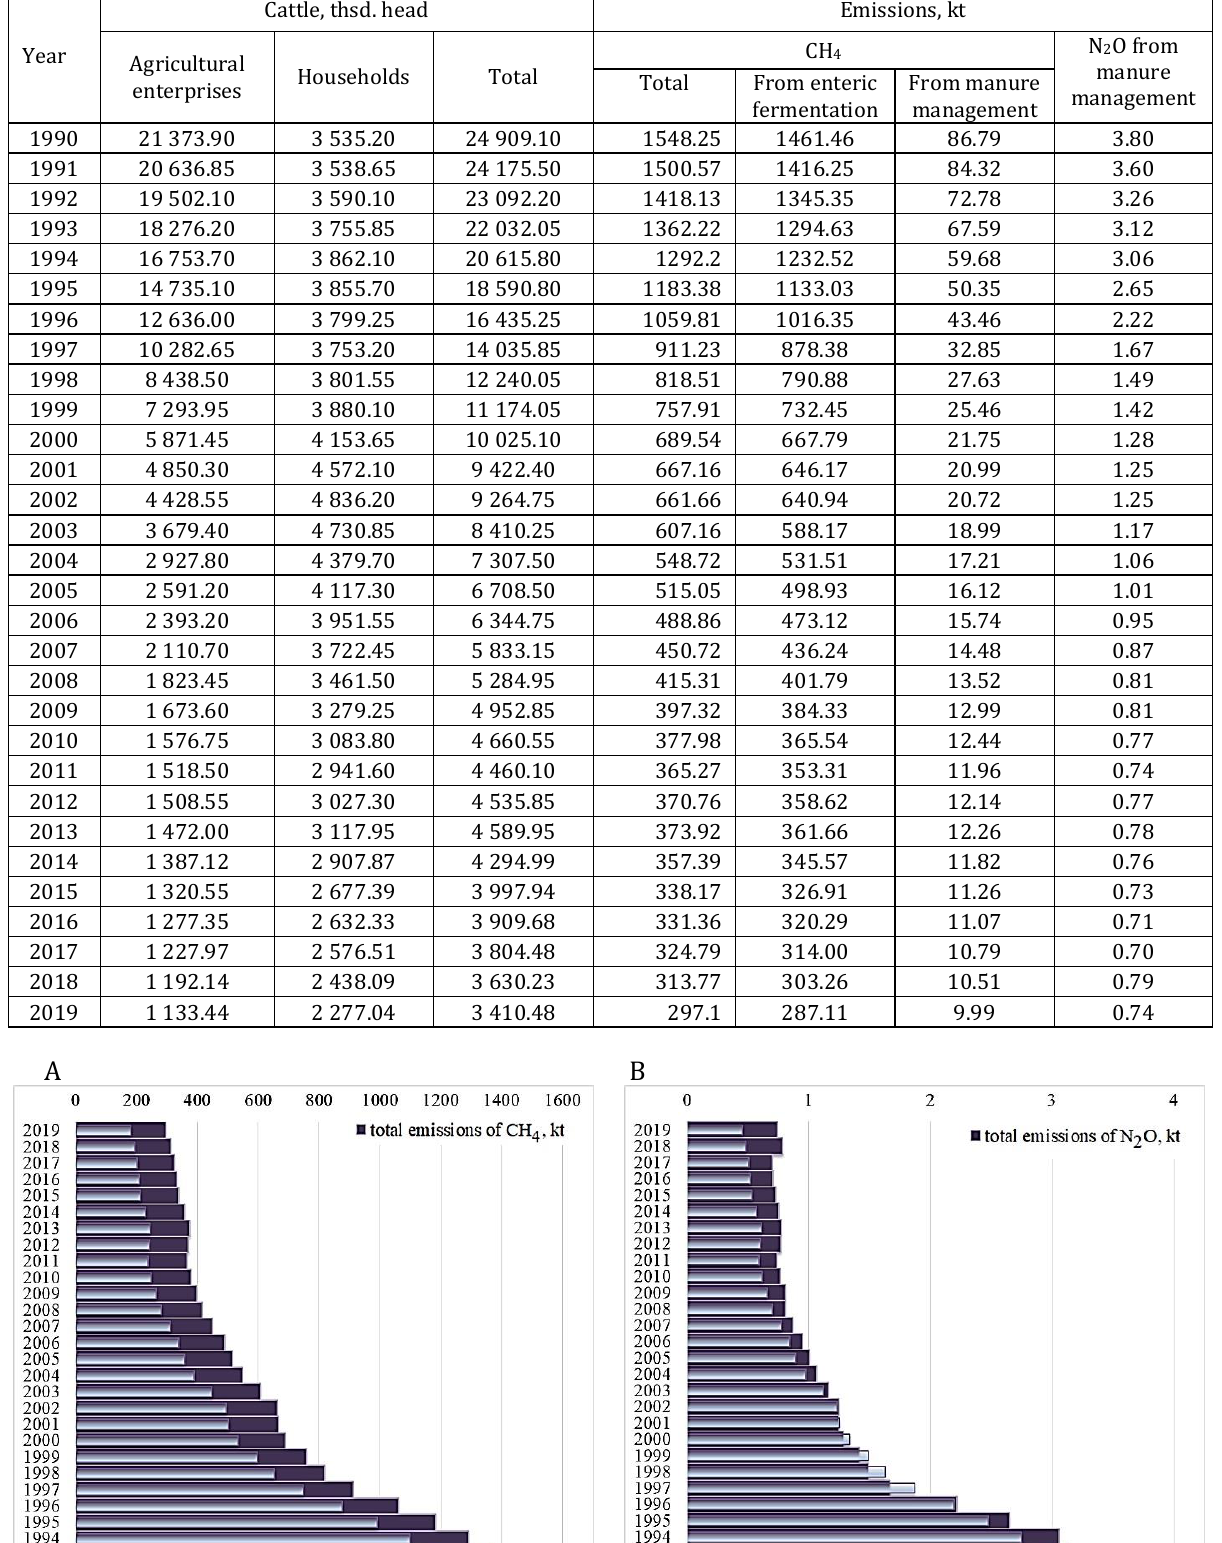
Table 1. The average annual livestock and their emissions in Ukraine Cattle, thsd. head Year